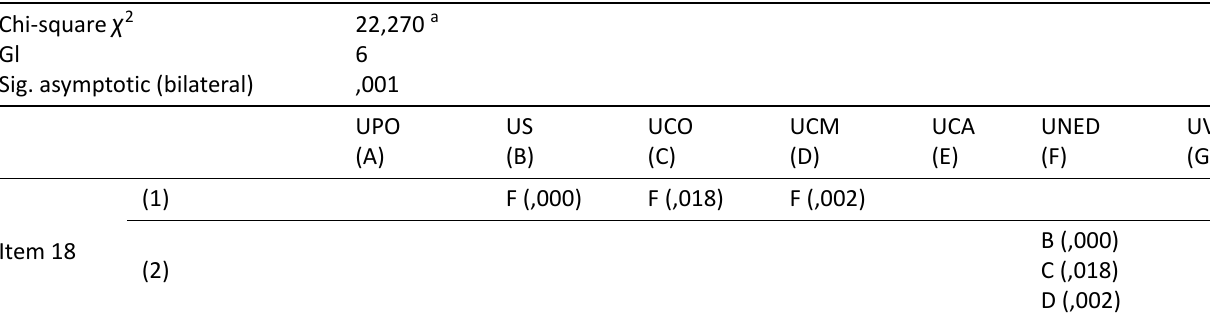
Table 7. Chi‐square and comparisons of proportions (item